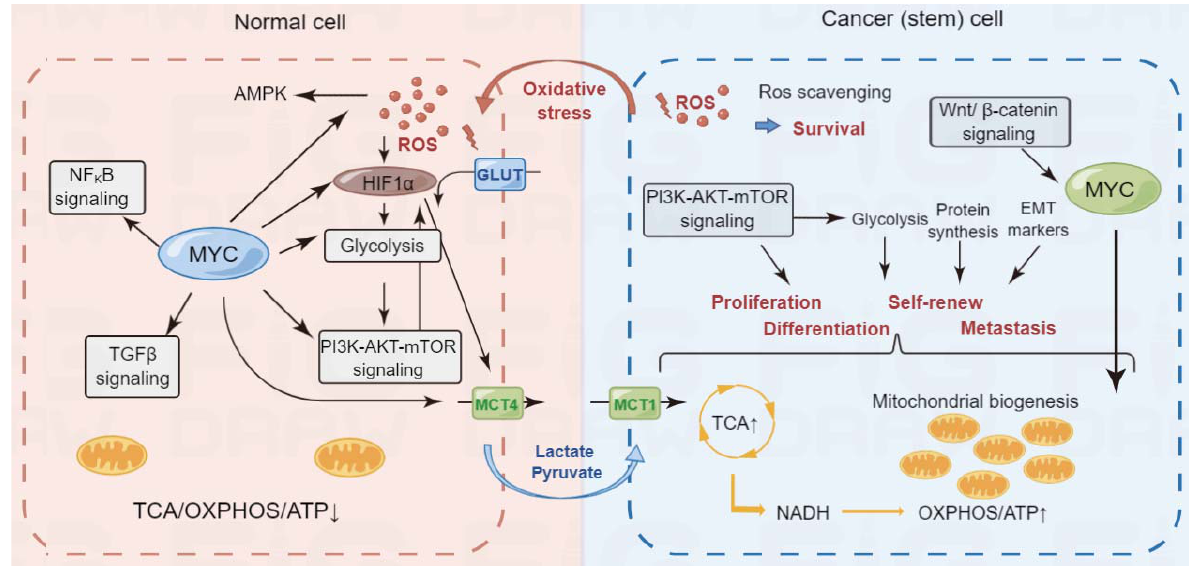
Figure 3. Metabolic difference between normal cells and cancer (stem) cells. Cancer stem cells exhibited enhanced glycolysis, catabolism of glutamate and fatty acids (FAs), which provided more intermediate metabolites tricarboxylic acid (TCA) cycle to generate more ATP. Signaling pathways, such as PI3K-AKT-mTOR pathway, which involved in the metabolic reprogramming in cancer stem cells, were also effective targets for cancer-targeted therapy. OXPHOS: oxidative phosphorylation; NADH: nicotinamide adenine dinucleotide reduced form; NAD: nicotinamide adenine